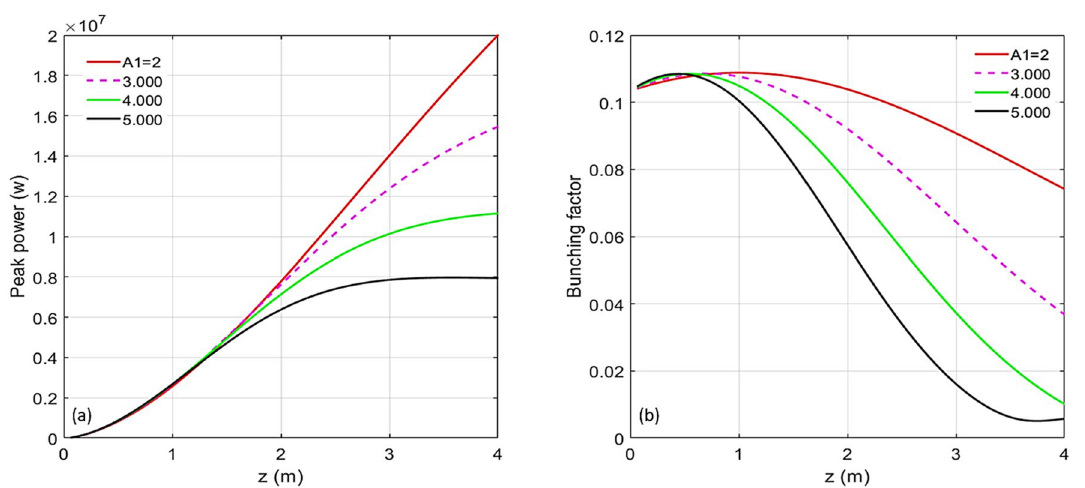
Figure 10. The energy modulation of stage 1 is scanned among the values of 2 (red), 3 (magenta), 4 (green), and 5 (grey) while the initial bunching is kept constant. ( a ) Peak power versus undulator position. ( b ) Bunching versus undulator